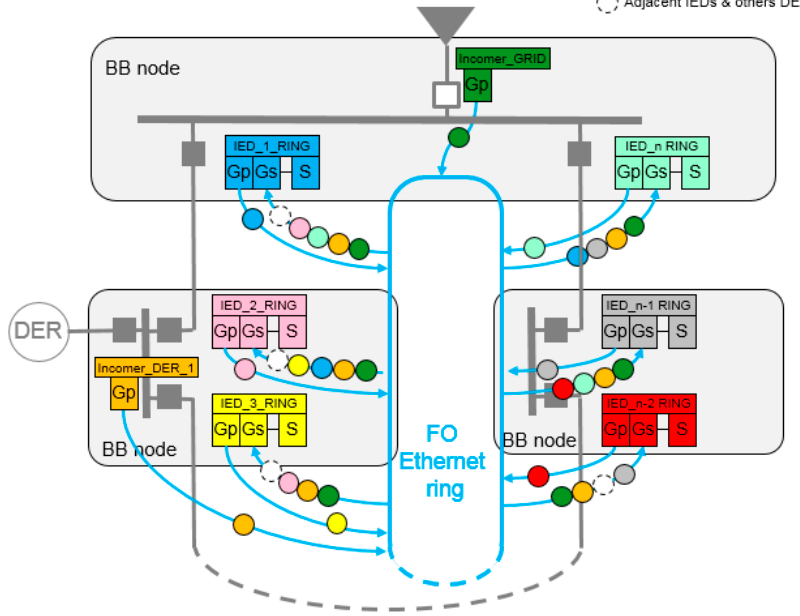
Figure 12. GOOSE flow in the communication network.